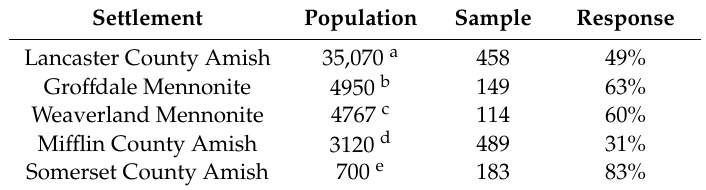
Table 1. Population estimates, sample sizes and response rates for five surveyed Plain communities. Settlement Population Sample Response Lancaster County Amish 35,070 a 458 49% Gro ff dale Mennonite 4950 b 149 63% Weaverland Mennonite 4767 c 114 60% Mi ffl in County Amish 3120 d 489 31% Somerset County Amish 700 e 183 83%